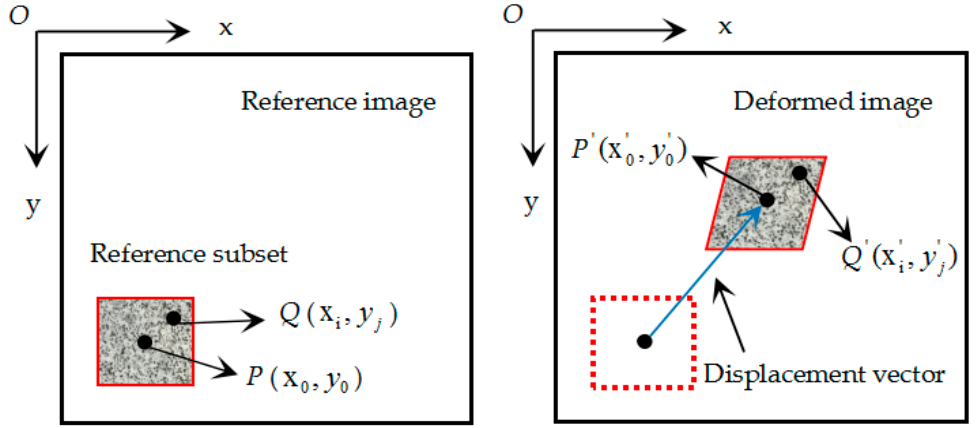
Figure 3. Schematic diagram of in-plane displacement and deformation of sub-regions.